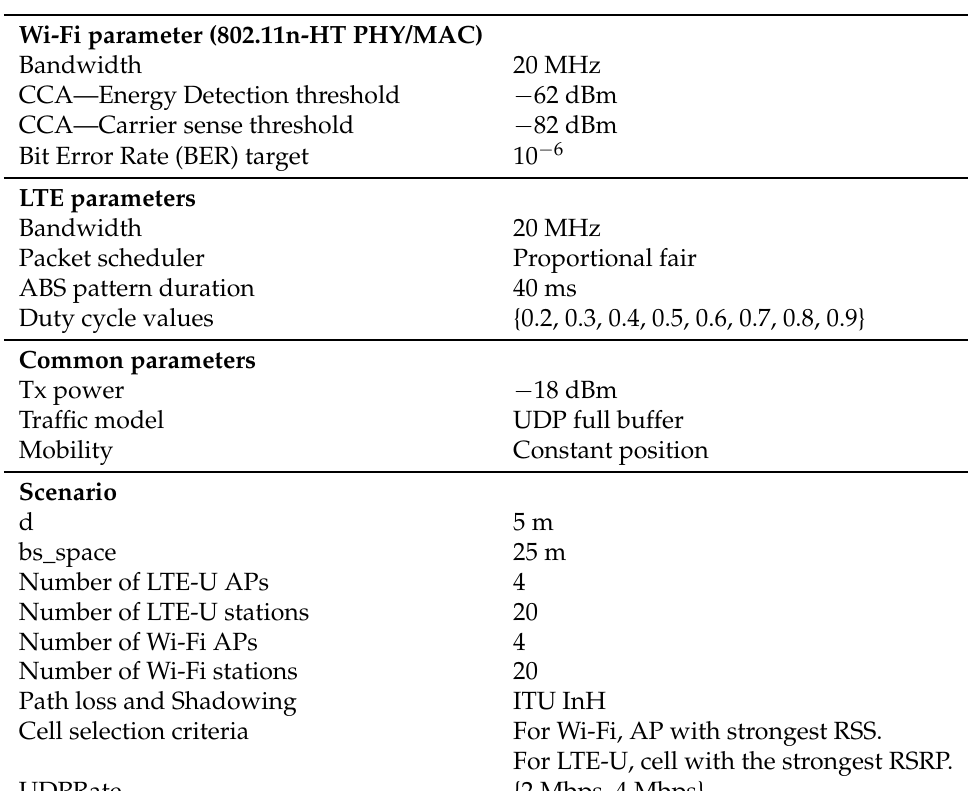
Table 1. Simulation parameters.